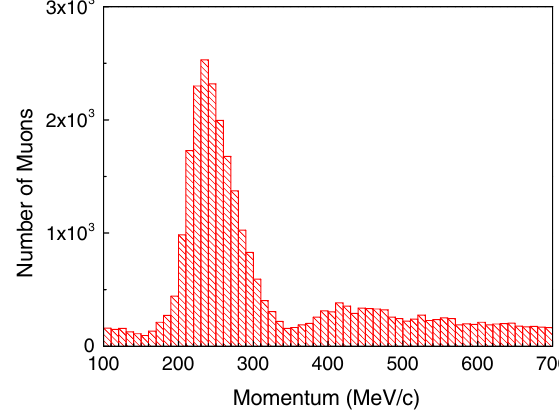
FIG. 8. Histogram of the momentum distribution of the beam at the entrance of the